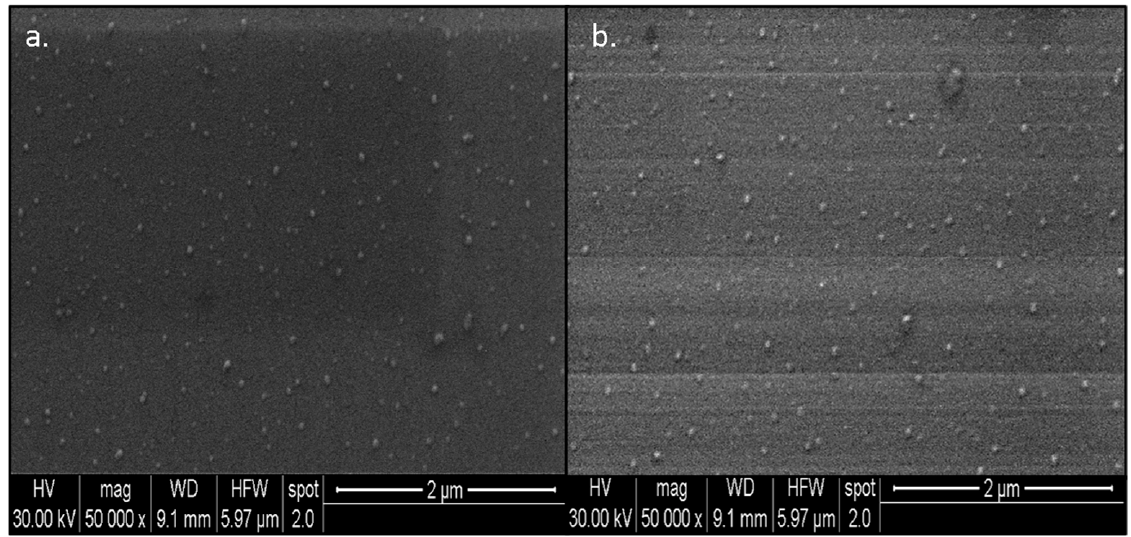
Figure 4. SEM images of ( a ) CX-AuNPs and ( b ) CT-AuNPs. To estimate the size of inorganic core of CX-AuNPs and CT-AuNPs, transmission electron microscopy (TEM) was applied. TEM images were taken at 1,000,000× magnifi- cation for both the AuNPs (Figure 5). TEM analysis revealed that both AuNPs samples were poly-dispersed, with mean size of 35 ± 17 nm and 45 ± 19 nm for CX-AuNPs and CT-AuNPs, respectively. There was no observed aggregation in the TEM and SEM images that corresponds to the successful capping of AuNPs by both the antibiotics (CX and CT). It is a fact that different measurement techniques will show variation in size of nanoparticles. Dynamic light scattering approach calculate the size including the adhered solvent layer, while TEM estimates the size of inorganic core [54,55]. Hence, size determination